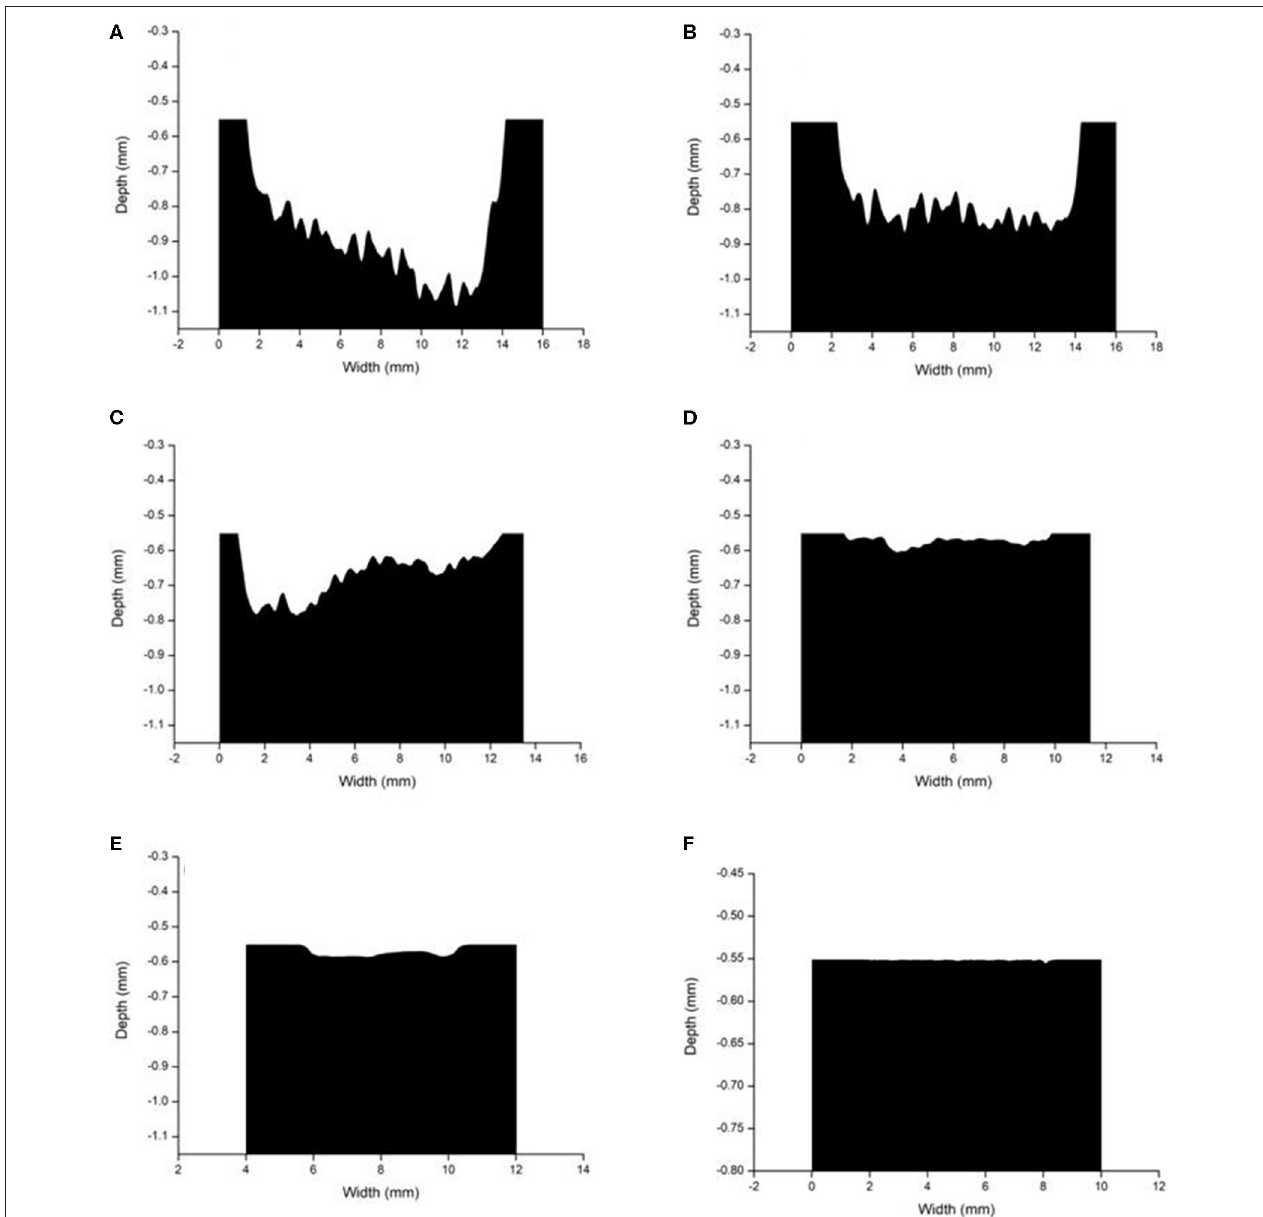
FIGURE 7 | Cross profiles of the samples’ worn surfaces with different Mo 2 C addition amount: (A) 0% Mo 2 C; (B) 1.2% Mo 2 C; (C) 2.4% Mo 2 C; (D) 3.6% Mo 2 C; (E) 4.8% Mo 2 C; (F) 6.0% Mo 2